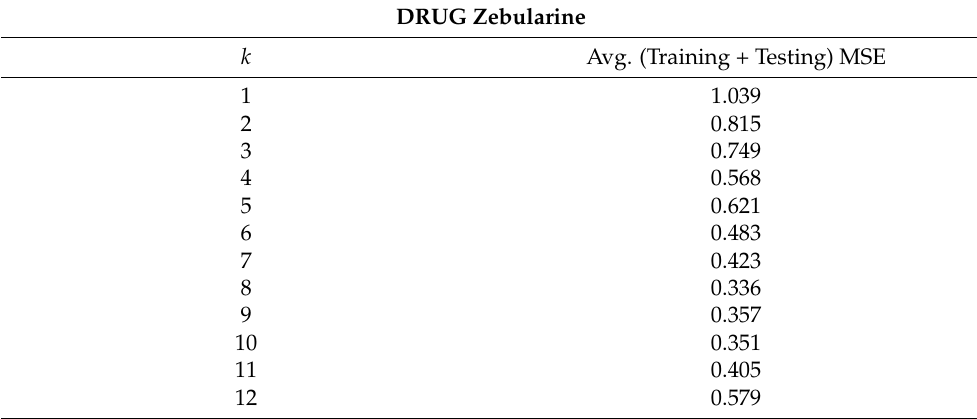
Table 6. Selection of optimal k value for kESVR model development of drug zebularine.